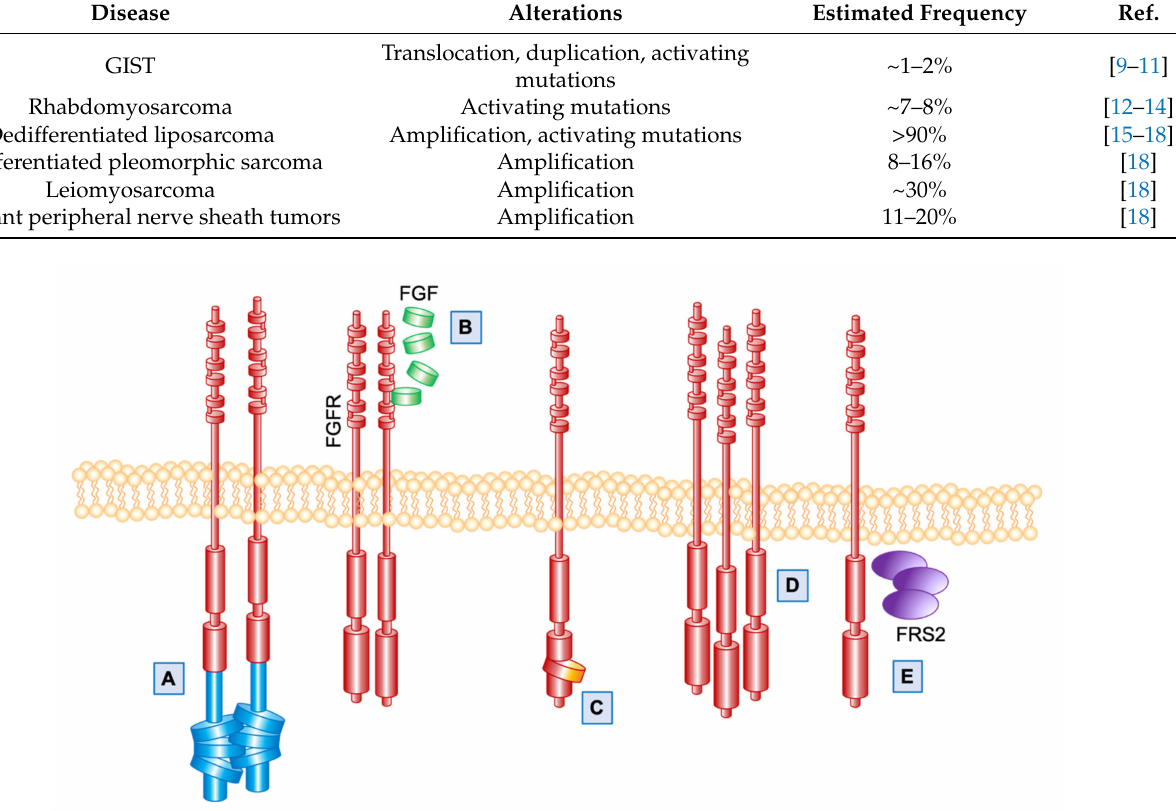
Figure 1. FGFR pathway alterations described in STS. ( A ) FGFR gene fusions; ( B ) overexpression of FGF ligands; ( C ) FGFR activating mutations; ( D ) FGFR overexpression (amplification or transcriptional modulation); ( E ) amplification of the FGFR adaptor protein